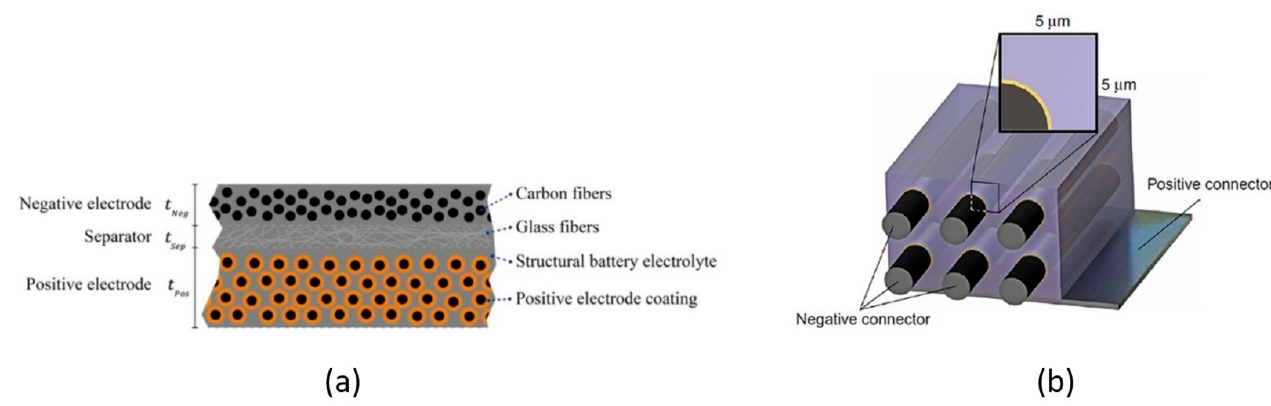
Figure 15. Conceptualization of composite structural batteries. ( a ) Laminated structural battery from Johannisson et al. [28]. ( b ) 3D structural battery from Carlson et al.